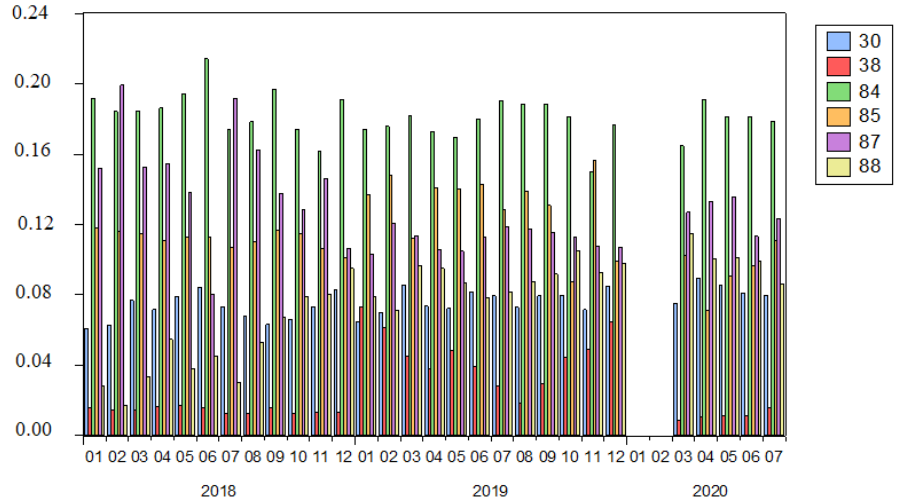
Figure 6. China imports—shares of the selected articles. Source: own investigation.